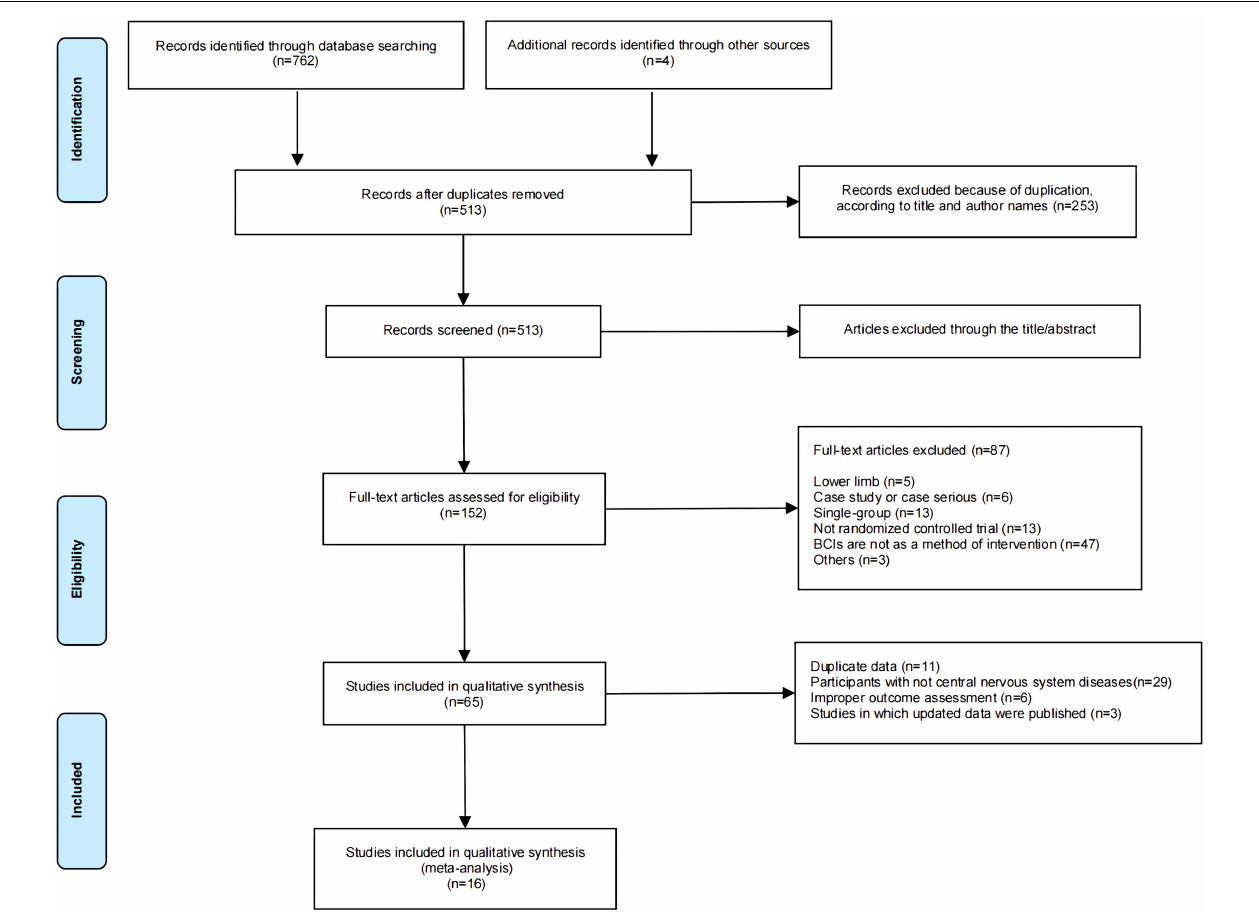
FIGURE 1 | Flowchart of the trial selection